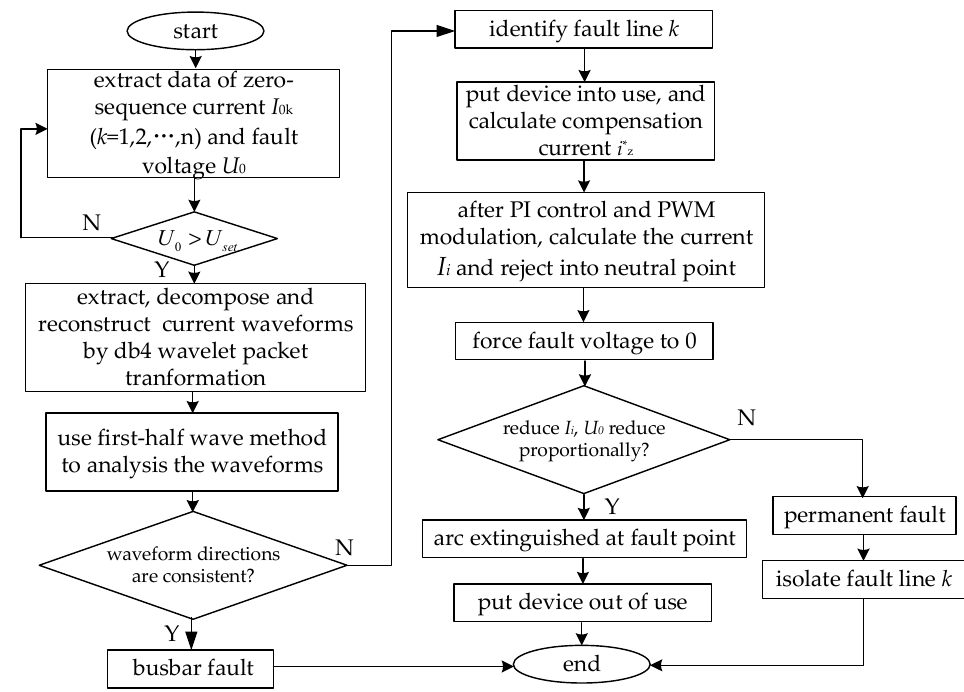
Figure 6. Flow chart of control strategy and fault detection algorithm.